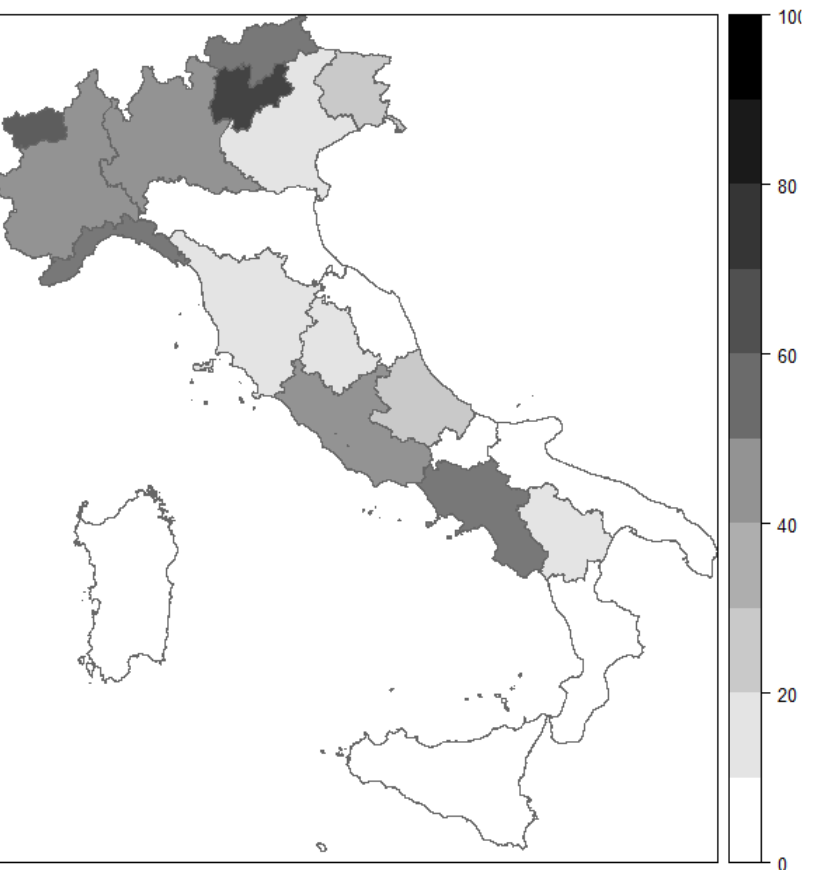
Figure 1. Share of immigrants by Region. Italian FADN sample